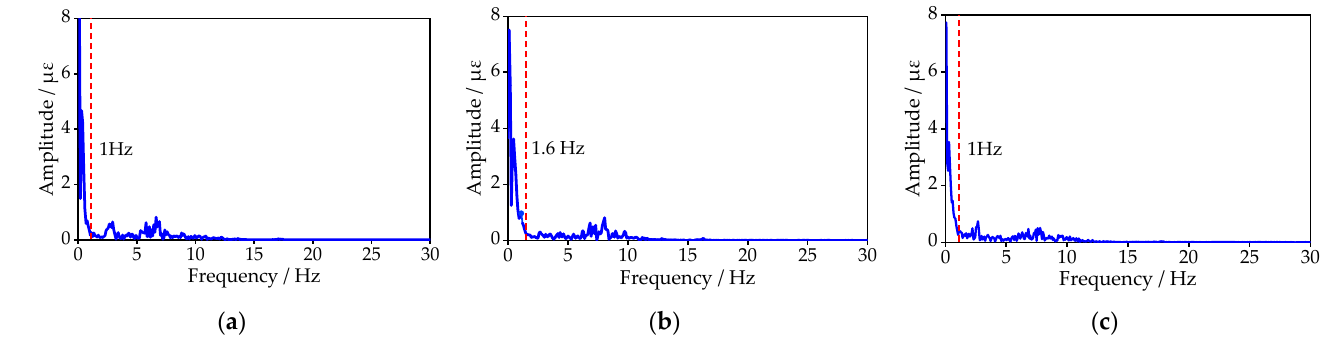
Figure 22. Measured dynamic strain of the bridge. ( a ) Response of the negative bending moment strain for the first measurement; ( b ) Response of the negative bending moment strain for the second measurement; ( c ) Response of the negative bending moment strain for the third measurement.